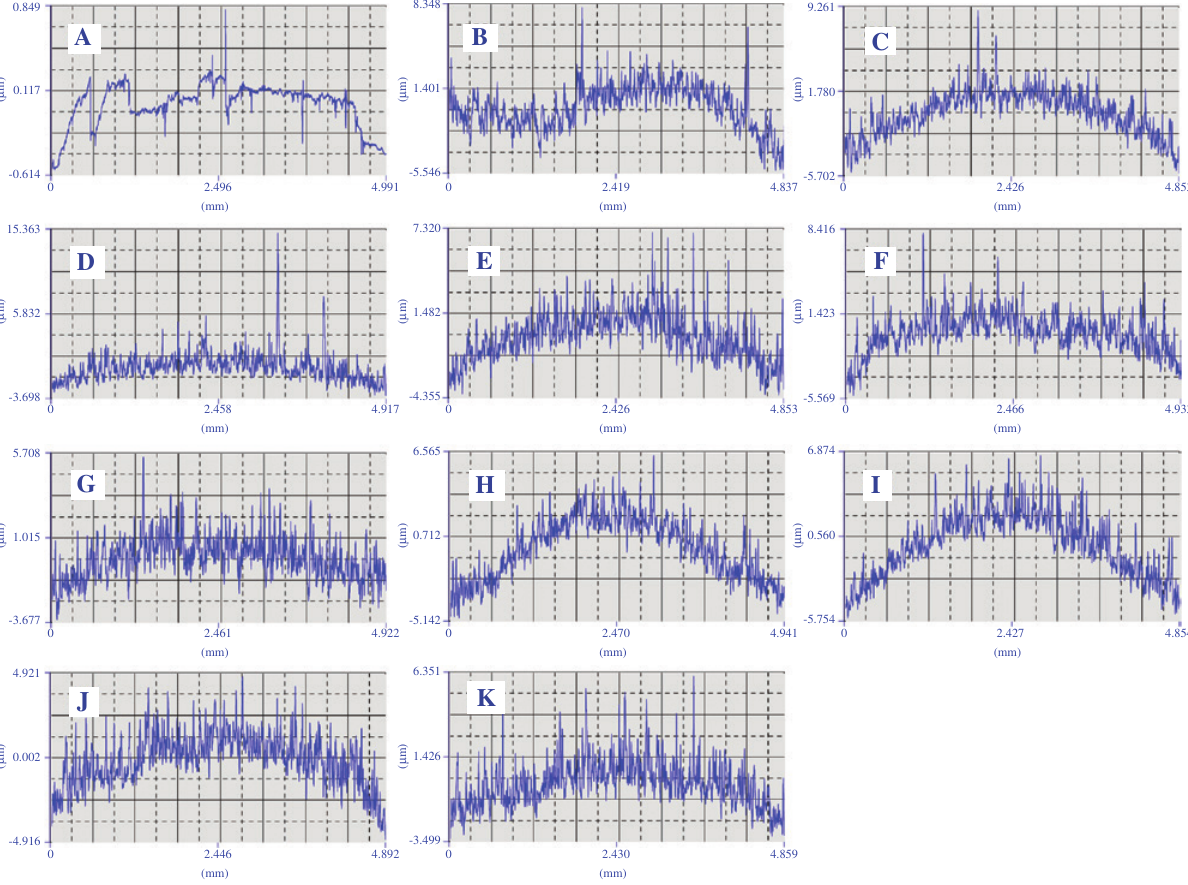
Figure 6 Waviness or surface roughness attitude images of polished (A), sandblasted (B), SLA for 10 s at 25 ° C (C), SLA for 20 s at 25 ° C (D), SLA for 30 s at 25 ° C (E), SLA for 10 s at 45 ° C (F), SLA for 20 s at 45 ° C (G), SLA for 30 s at 45 ° C (H), SLA for 10 s at 60 ° C (I), SLA for 20 s at 60 ° C (J), and SLA for 30 s at 60 ° C